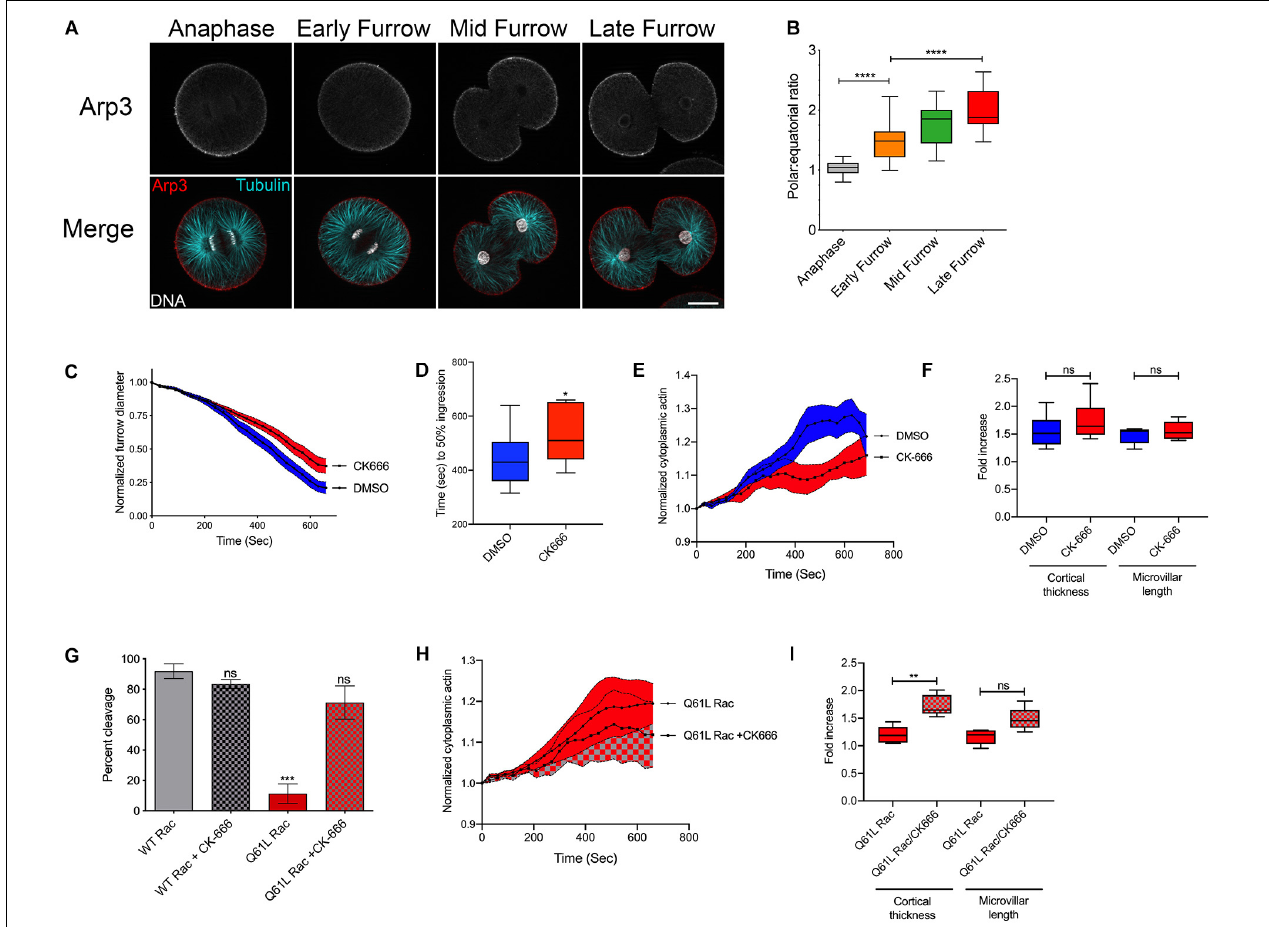
FIGURE 3 | Activated Rac suppresses cytokinesis through Arp2/3. (A,B) S. purpuratus embryos probed for Arp3 (top row in grayscale, red in the merged image), tubulin (cyan), and DNA (White). Bar, 30 µ m. As cytokinesis progresses, Arp2/3 is increasingly excluded from the furrow region. **** p < 0.0001. (C) Arp2/3 delays but does not block cytokinesis. Embryos were treated with 0.1% DMSO or 100 µ M CK-666 prior to nuclear envelope breakdown, and furrow diameter was measured by Nomarski/DIC starting at the initiation of furrowing (mean ± SEM, n = 13 for DMSO, n = 12 for CK-666). (D) Comparison of the rates of furrowing (time to 50% ingression), * p < 0.05. (E) Quantification of cytoplasmic actin levels in either DMSO- or CK-666-treated embryos beginning 1 min post-NEB up until the metaphase-anaphase transition (Mean ± SEM, n = 6 cells per condition). (F) Quantitation of the increases in cortical thickness and microvillar length